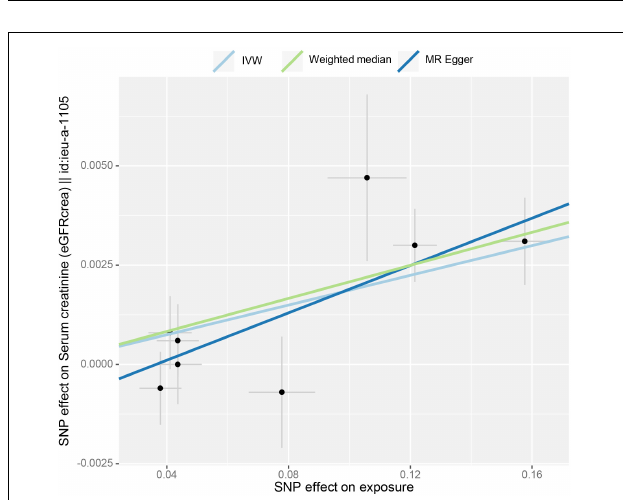
FIGURE 3 | Scatter plot of the effect size for each SNP on tea consumption and the estimated glomerular filtration rate (eGFR).